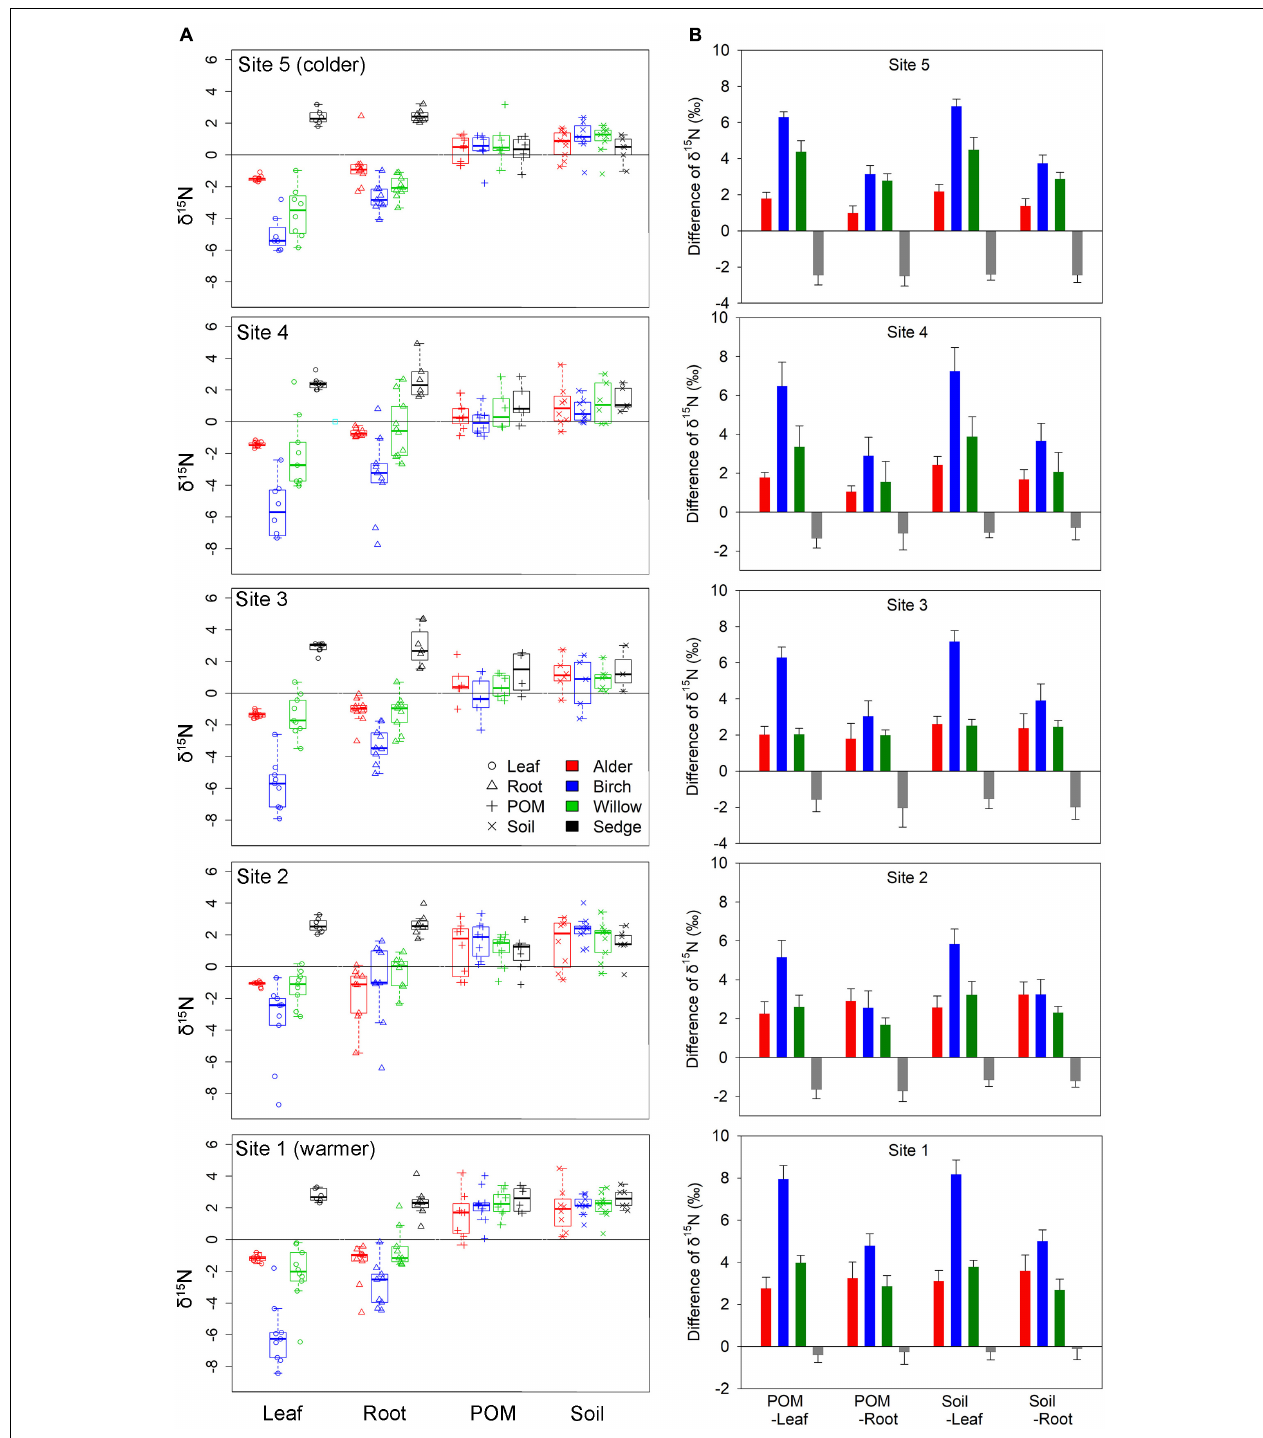
FIGURE 6 | (A) The δ 15 N values of leaf, root, organic layer soil and its particulate organic matter (POM) component among plots with four different dominant genera at the five sites. Leaf and root δ 15 N were significantly influenced by dominant genus ( P < 0.001, Sedge > Alder, Willow > Birch for both leaf and root) but not site location ( P = 0.13 for leaf and 0.77 for root); soil and POM δ 15 N were significantly influenced by site location ( P < 0.001, Site 1 > Sites 2, 3, 4, 5; Site 2 > Site 5 for both soil and POM) but not dominant genus ( P = 0.89 for soil and 0.34 for POM); (B) Pair-wise comparison of soil δ 15 N (and POM component) vs. plant δ 15 N (leaf and root) among plots with four different dominant genera of the five sites. In shrub-dominated plots, plant δ 15 N (both leaf and root) was lower than the corresponding organic layer soil and POM δ 15 N, whereas in sedge-dominated plots the plant δ 15 N was higher than soil and POM δ 15 N. Effects of dominant genus on the difference in δ 15 N between soil and plant were significant across all sample sites ( P < 0.001).